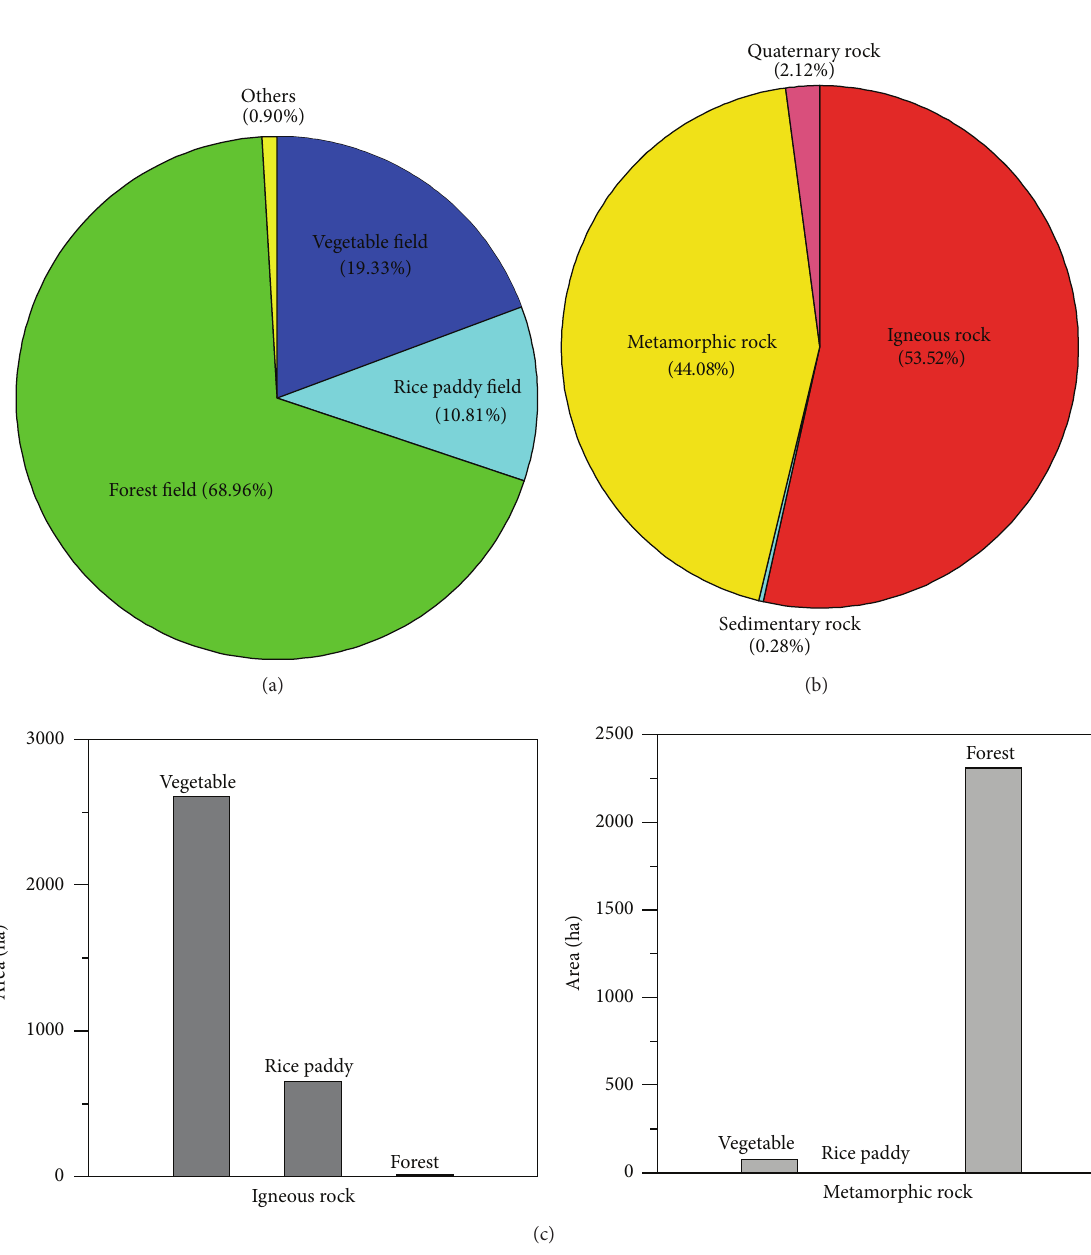
Figure 2: Land uses and soil parent materials in the Haean basin,